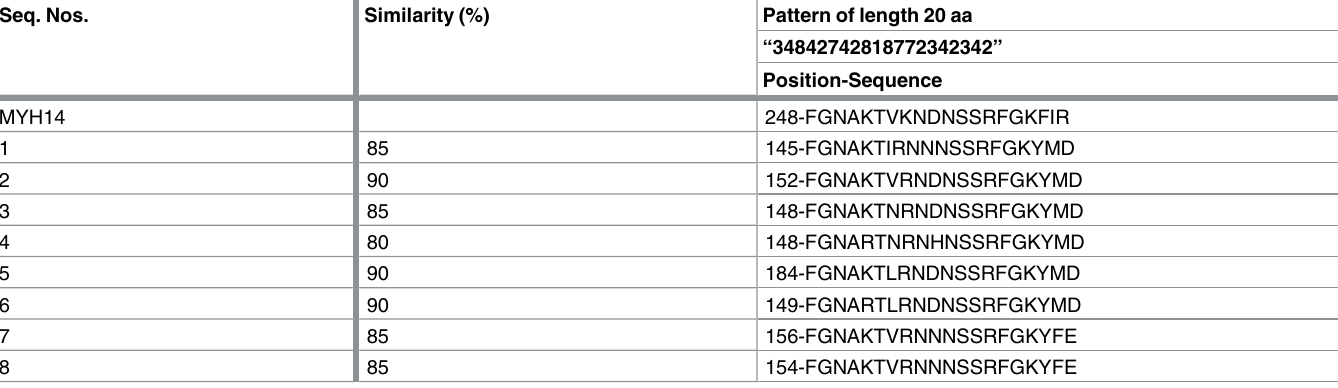
Table 18. Comparison of common motifs from Myosin II with MYOI class of myosin, their position and sequences. Seq.